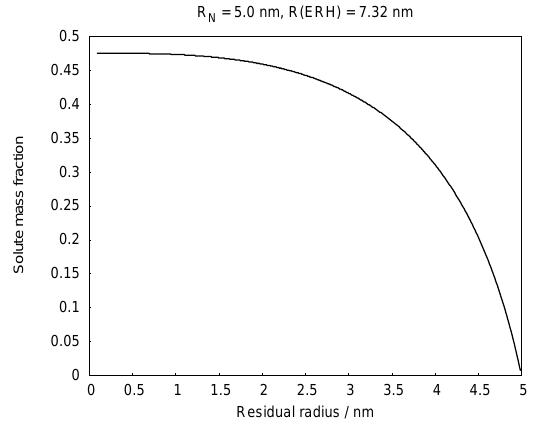
Figure 4. Solute mass fraction x m as a function of the residual ra- dius R (cid:48) N